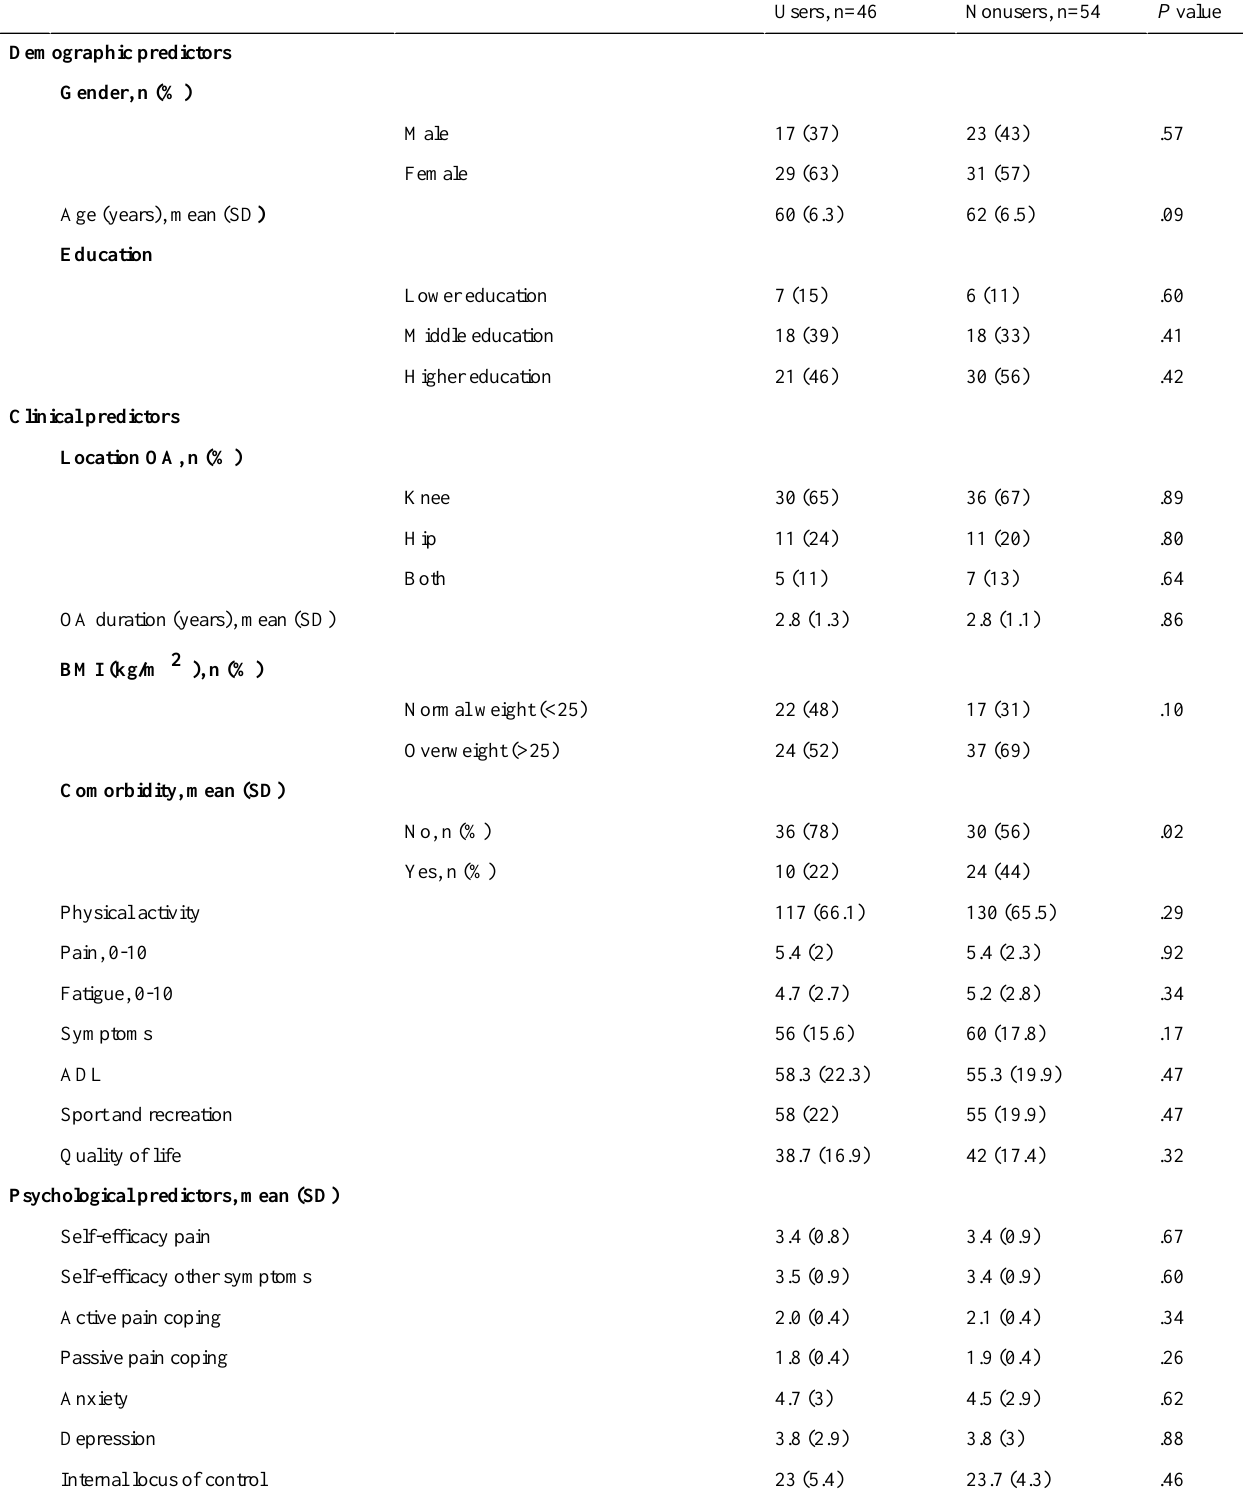
Table 1. Baseline demographic and clinical